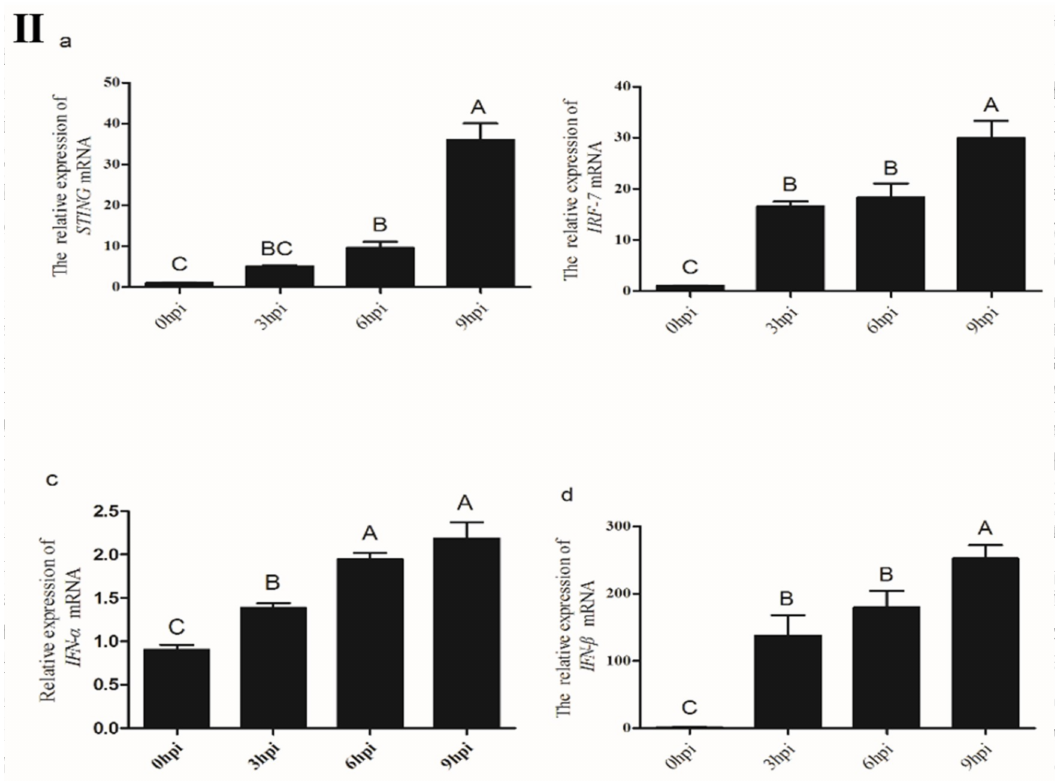
Figure 9. The expression levels of STING , IRF7 , IFN- α and IFN- β genes in CEFs after transfection with poly(dA:dT). (I) CEFs were transfected with different doses of poly(dA:dT) for 9 h and then analyzed for the expression levels of STING , IRF7 , IFN- α and IFN- β genes by real-time PCR. (II)After transfection with the poly(dA:dT), the expression levels of STING , IRF7 , IFN- α and IFN- β genes in CEFs were analyzed at 3, 6, 9 h, respectively. All data shown are the mean ± SD ( n = 3) and subjected into one-way ANOVA to identify differences between groups. Columns sharing different capital letters show significant difference ( p <